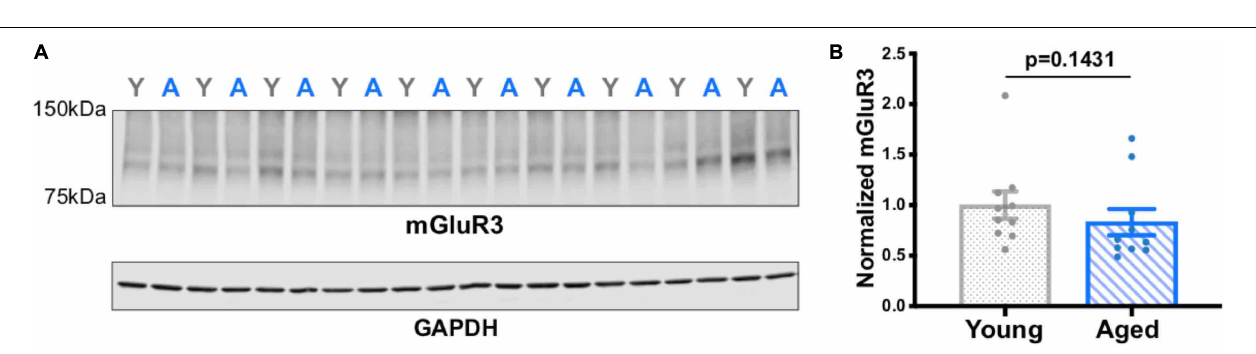
FIGURE 4 | GCPII levels in young vs. aged rat frontal cortex. (A) Rat frontal cortex tissue (18 µ g of protein loaded per well) was immunoblotted for GCPII and GAPDH. Each lane represents a single animal and is labeled either young (gray Y) or aged (red A). (B) Quantification of GCPII normalized by GAPDH grouped by age. Young animals ( n = 10) and aged animals ( n = 10) are compared via an independent t -test (*** p = 0.0004). SEM is plotted for each group.